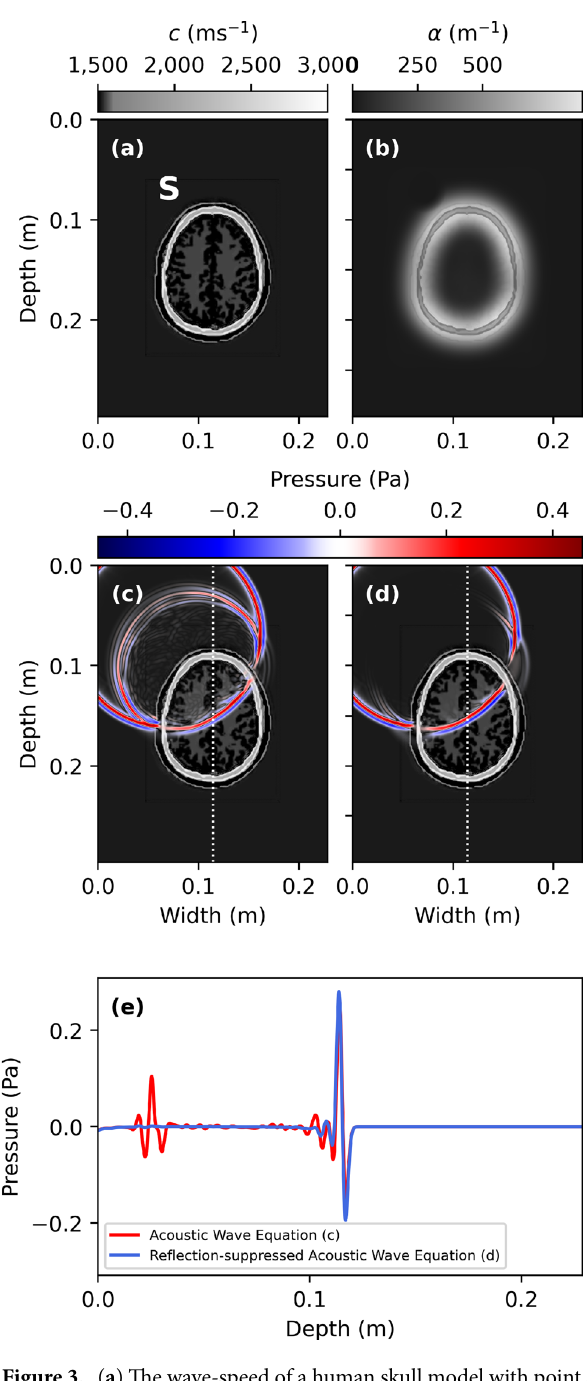
Figure 3. ( a ) The wave-speed of a human skull model with point source location S and ( b ) local suppression constant α( (cid:31) r ) . ( c ) shows a snapshot of the wave-field at t = 7.44 · 10 − 5 s for the acoustic wave equation (1, 2) and ( d ) the reflection-suppressed wave equation (3, 4), using a peak frequency of 200 kHz, 10 grid-points per smallest wavelength, and a CFL 20 number of 0.5. The resulting space interval and step-size become (cid:31) x = 2.45 · 10 − 4 m and (cid:31) t = 5.32 · 10 − 8 s, respectively. ( e ) shows a cross-section through snapshots ( c ) and ( d ) along the white dotted-line. A video of all snapshots is available as supplementary